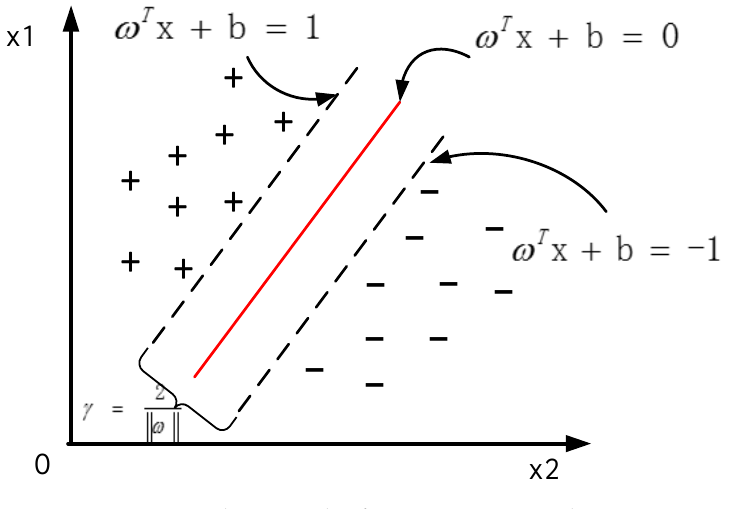
Figure 6. The principle of Support Vector Machine.